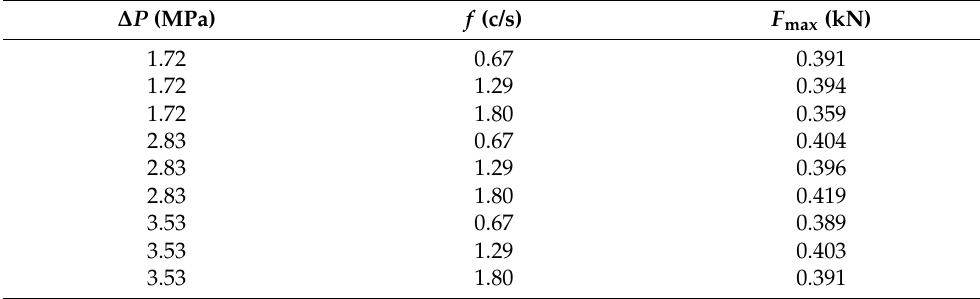
Table 6. F max corresponding to each group of ∆ P and